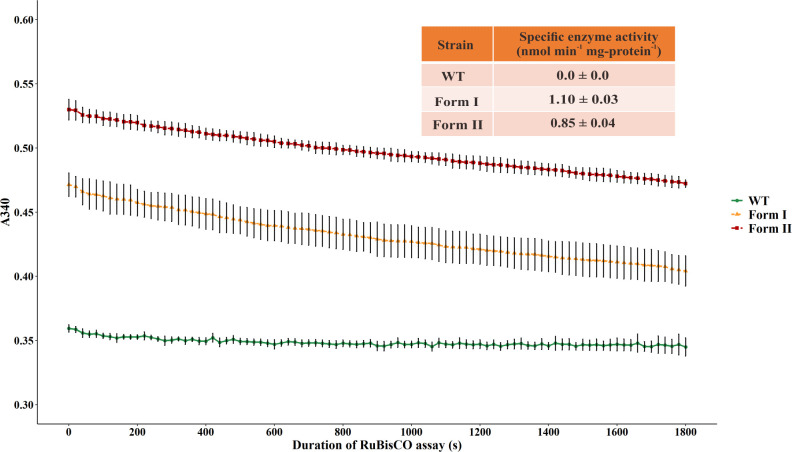
Specific RuBisCO enzyme activity.The line plot represents the decrease in A340 absorbance, indicating NADH oxidation throughout the RuBisCO assay. The table displays specific RuBisCO activity of form I and form II RuBisCO.